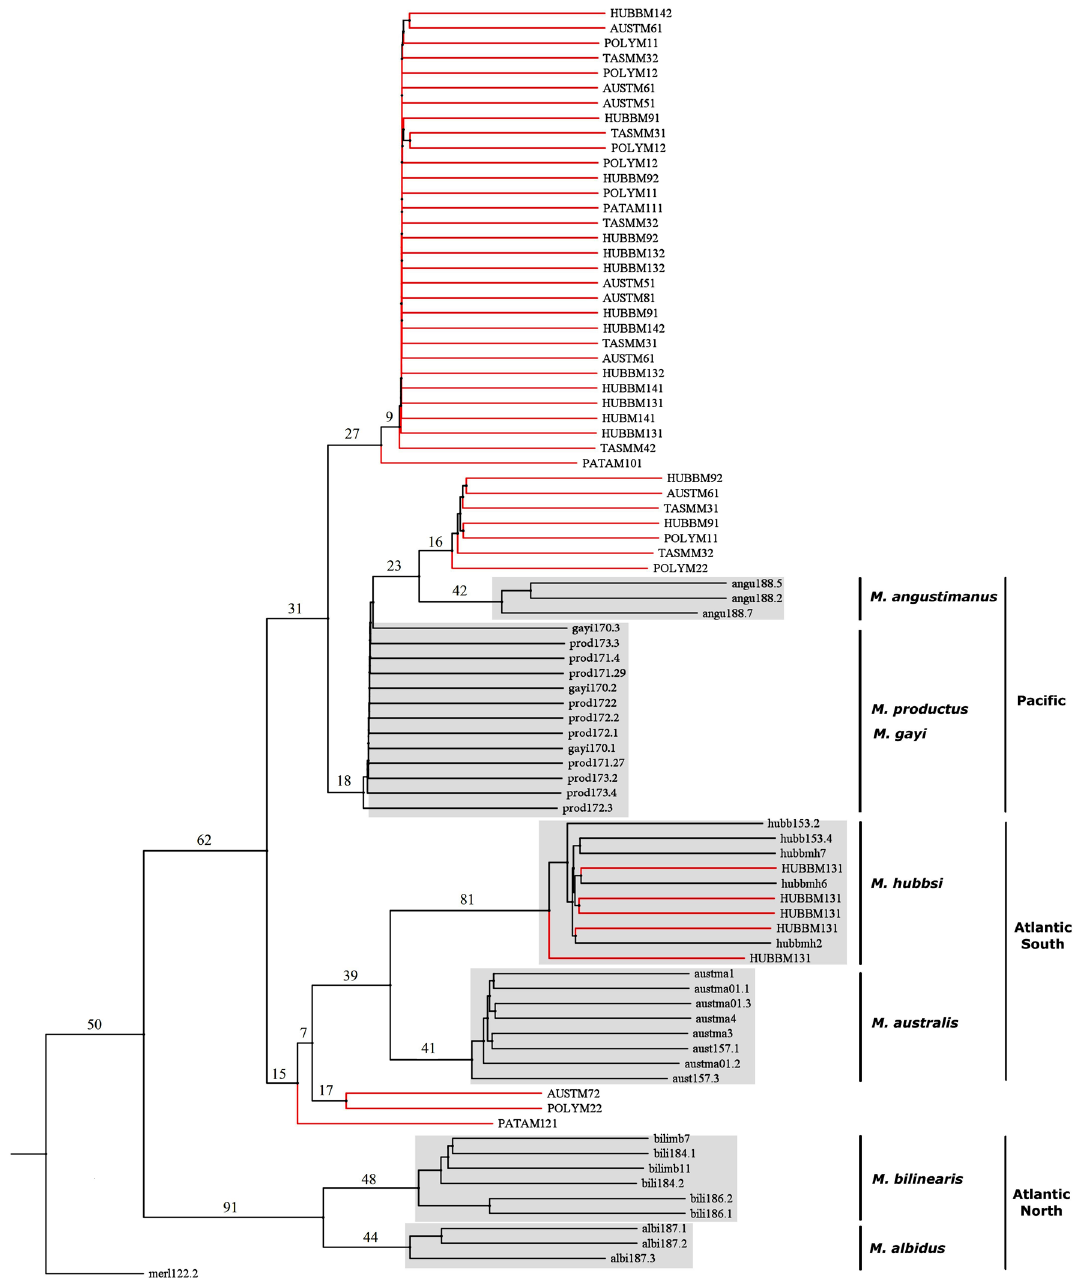
Figure 6. Phylodiagnostic NJ tree (sensu 18 ) on ITS1Nes sequences after PHYLIPv3.6 84 built to allocate morphotype clones (red branches and codes in uppercase) to the phylogenetic backbone of genus Merluccius spp. from the New World (clusters in grey rectangles, black branches and codes in lowercase). The percentage of trees over 1000 bootstrap replicates are shown above branches. Codes for valid species are given in Table 1 and are followed by the alphanumeric entry code for each specimen in the authors laboratory, e.g. aust_ma01_3 is the specimen No. 3 of sample ma01 from M. australis (aust). Codes for morphotypes are given in Table 2 and are followed by an alphanumeric entry from the authors laboratories (Supp. Table S9), e.g. TASM_M3_1 is a ITS1Nes sequence from muscle tissue (1) of specimen M3 (M3) of morphotype M. tasmanicus differs substantially from any other single-marker reconstruction. The Old World supercluster is believed to have experienced strong bottlenecks after the early divergence of M. polli and M. paradoxus, followed by a later speciation of M. merluccius , M. capensis and M. senegalensis 52 . A consensus exists on the monophyly of those two clusters 8,14,15,52 . Such phylogenetic partition is biogeographically counterintuitive since sympatric M. cap- ensis and M. paradoxus in Atlantic South Africa are believed to emerge from two independent dispersions of North Atlantic taxa along the west coast of Africa 58 . Moreover, provided that M. polli and M. paradoxus are two